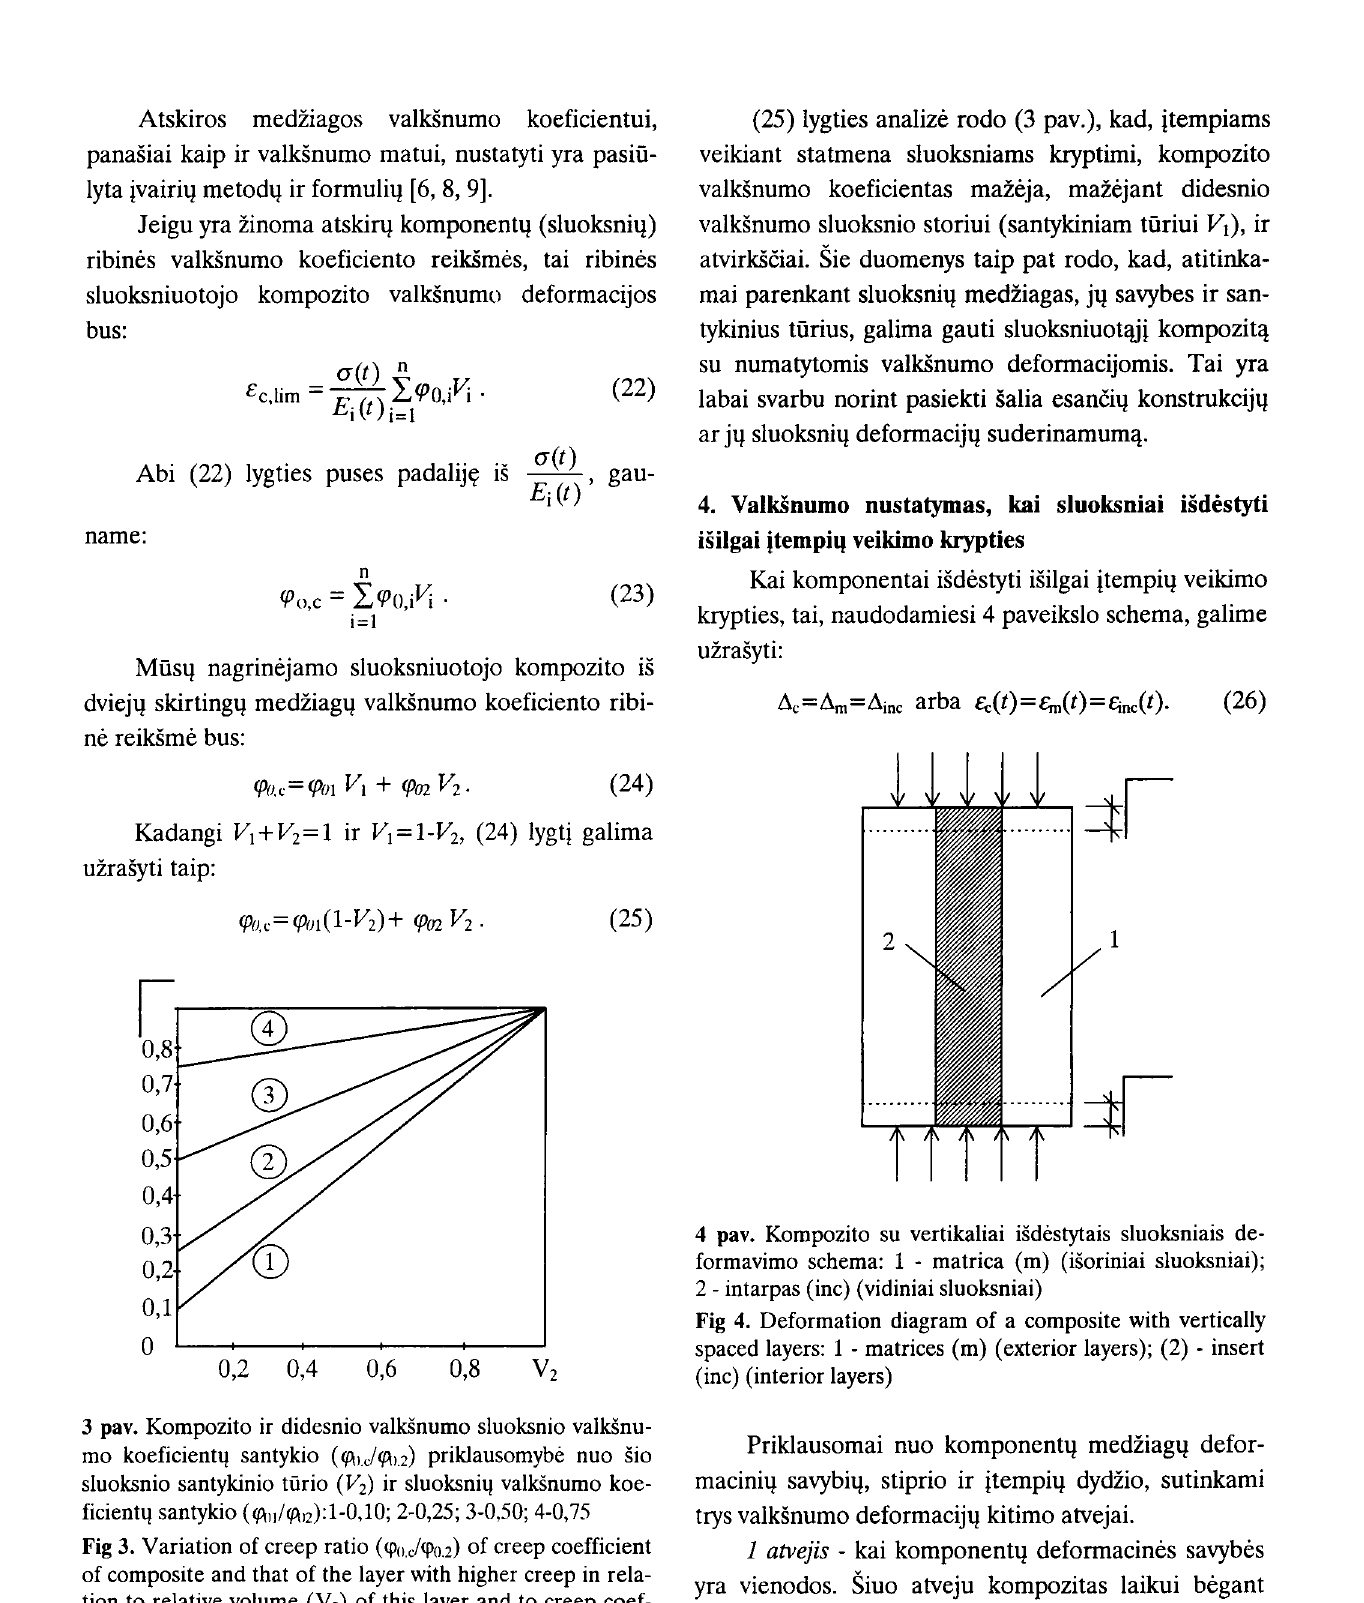
3 pav. Kompozito ir didesnio valkSnumo sluoksnio valksnu mo koeficientq santykio ( f{Jt.1)f{Jt.l.2) priklausomybe nuo sio sluoksnio santykinio tiirio (V 2) ir sluoksniq valksnumo koe ficientq santykio (ffJt. 11/f{Jt.l2 ):1-0,10; 2-0,25; 3-0,50; 4-0,75 Fig 3. Variation of creep ratio ( <p 0 J<p 0_2) of creep coefficient of composite and that of the layer with higher creep in rela tion to relative volume (V 2) of this layer and to creep coef ficient rations of layers ( <pru/<pri.Z): 1-0.10; 2-0.25; 3-0.50; 4- 0.75 (24) ir (25) lygtys rodo, kad, zinant atskirq kom ponentq valksnumo koeficientq ribines reiksmes ir jq santykinius tiirius, galima apskaiCiuoti sluoksniuotojo kompozito valksnumo koeficiento ribin~t reiksml(.